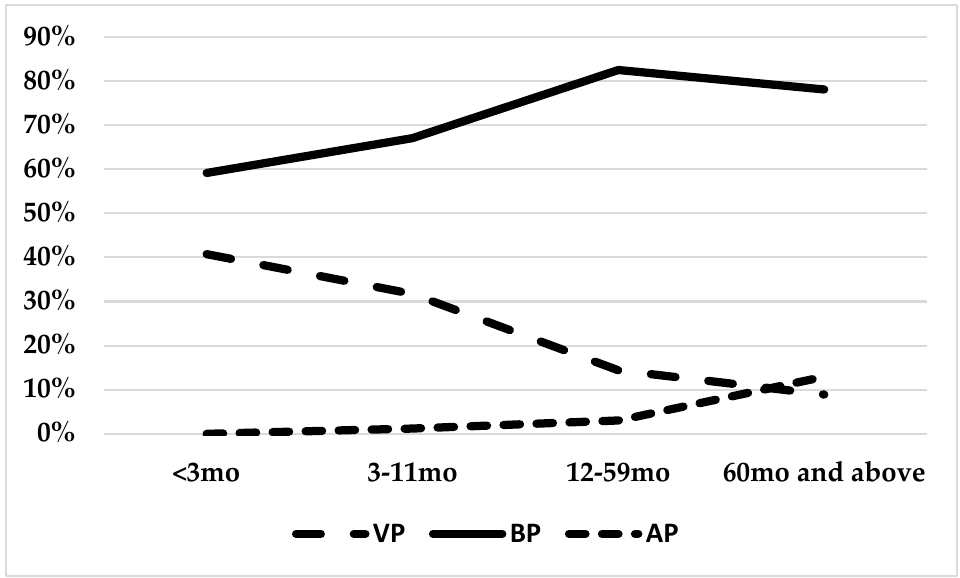
Figure 2. Frequency of pneumonia etiological factors in different age groups (VP—viral pneumonia; dashed line; BP—bacterial pneumonia, solid line; AP—atypical pneumonia, dotted